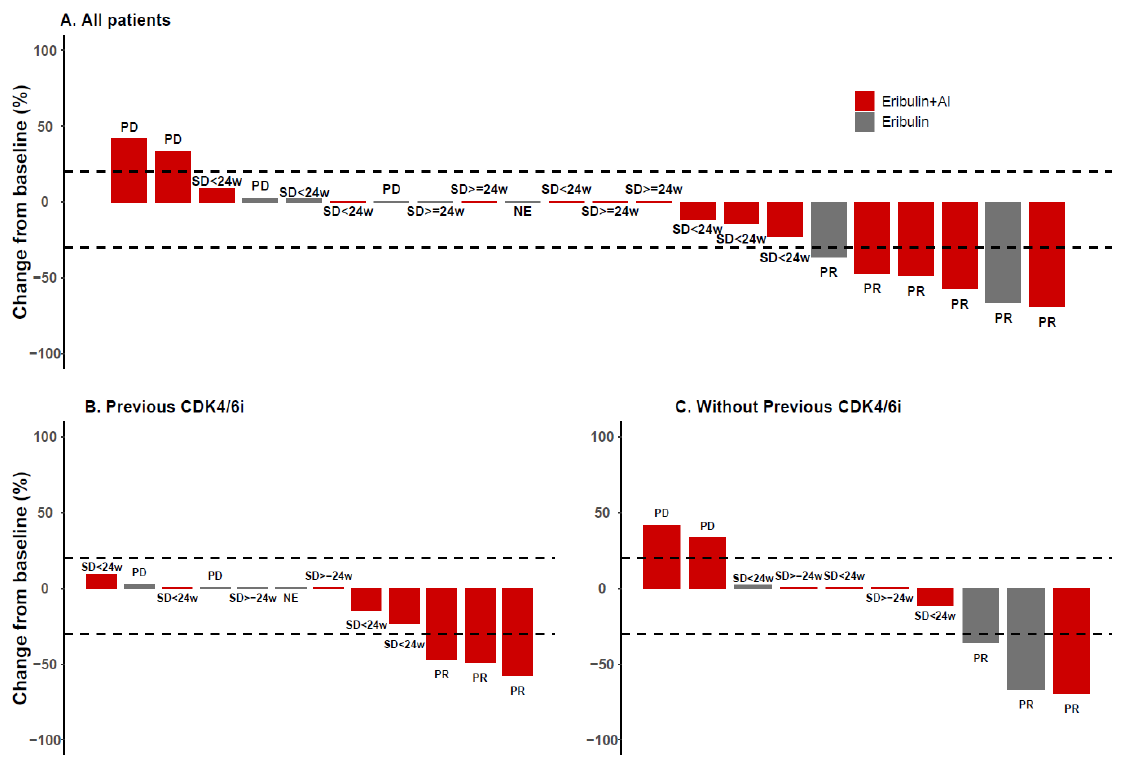
Figure 2. Overall response rate of patients who received eribulin + AI or eribulin only, according to prior treatment with CDK4/6i. ( A ) All patients, ( B ) CDK4/6I in previous line, ( C ) without previous CDK4/6i in previous line. AI, Aromatase inhibitors; CDK4/6i, Cyclin-dependent kinases 4 and 6 inhibitors; PD, Progressive disease; PR, Partial response; SD, Stable disease; NE, Not evaluable.